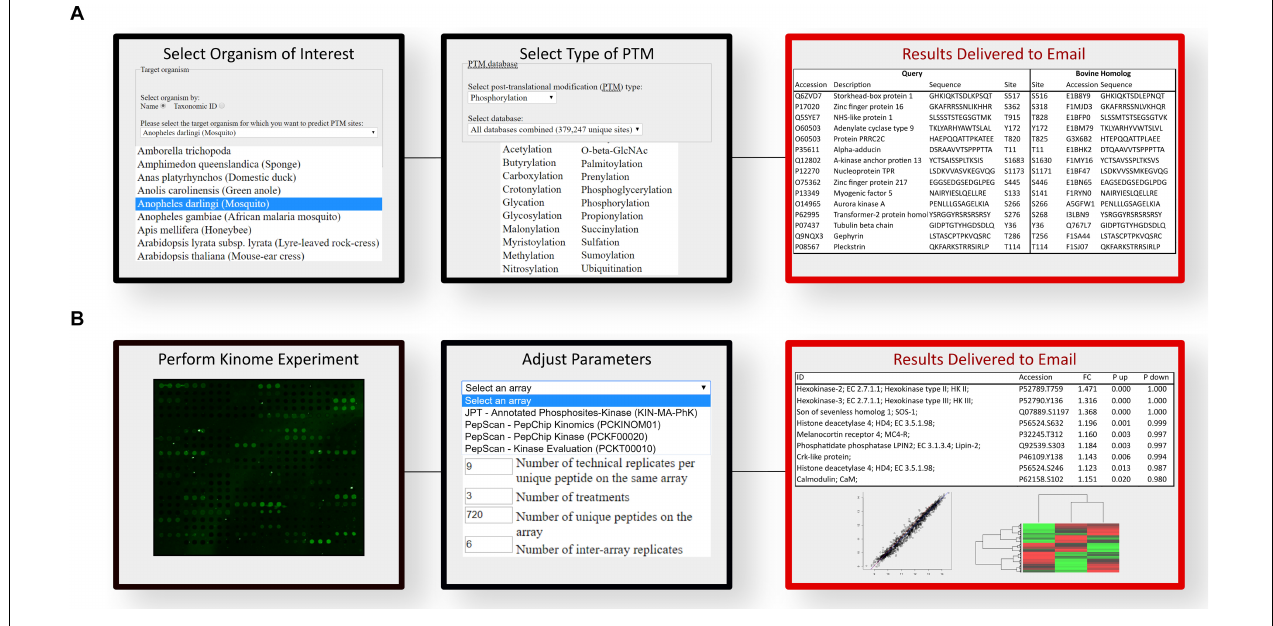
FIGURE 2 | Computational workflow for the prediction of phosphopeptides and analysis of kinome array data. (A) DAPPLE2 facilitates the prediction of post-translational modification sites in proteins. Specific to kinome technology, DAPPLE2 can predict and generate a list of all putative phosphopeptides from the selected species of interest. (B) PIIKA2 software was custom designed for the transformation, deconvolution, statistical analysis and visualization of kinome array data. PIIKA2 results returned to the user include various statistical analyses and data visualization such as principal component analysis plots, scatter plots, and hierarchical clustering heat maps. Both software platforms are freely accessible to all researchers at